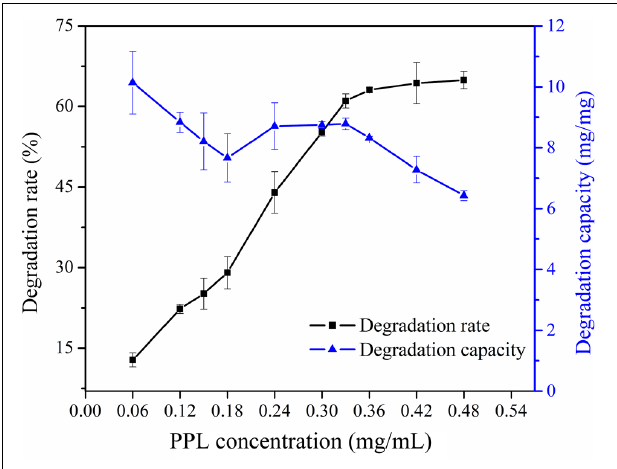
FIGURE 2 | Effect of enzyme concentration on degradation rate and degradation capacity of PPL for